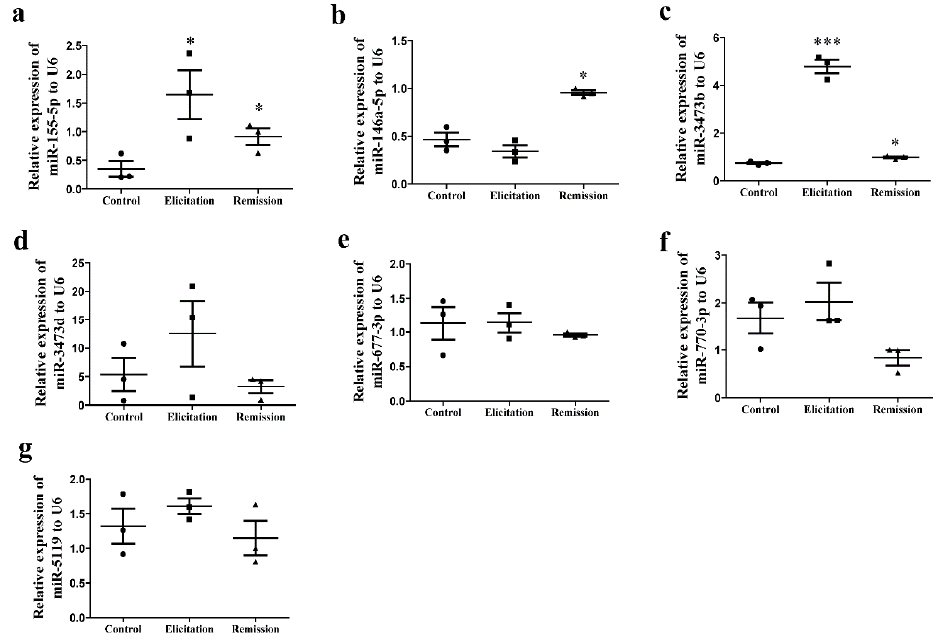
Figure 7. Confirmation of microarray results in the same samples from ear tissue homogenate in the remission and elicitation phase of the AD recurrence model. ( a – g ) The expressions of miR-155-5p, miR-146a-5p, miR-3473b, miR-3473d, miR-677-3p, miR-770a-5p, and miR-5119 were detected by qRT-PCR (mean ± SD, n = 3, * p < 0.05, *** p < 0.01 versus A). 2.7. Validation of Dysregulated lncRNAs in the Remission of AD Recurrence Model Based on bioinformatic prediction results, we selected seven lncRNAs identified from the ear tissue of mice to validate lncRNAs via qRT-PCR analysis. LncRNAs humanlincRNA0016+, uc008thl.1, uc029qxr.1, and AK077345 were upregulated (Figure 8a), while uc029ycn.1, ENSMUST00000164311, and ENSMUST00000149791 were downregulated (Figure 8b).